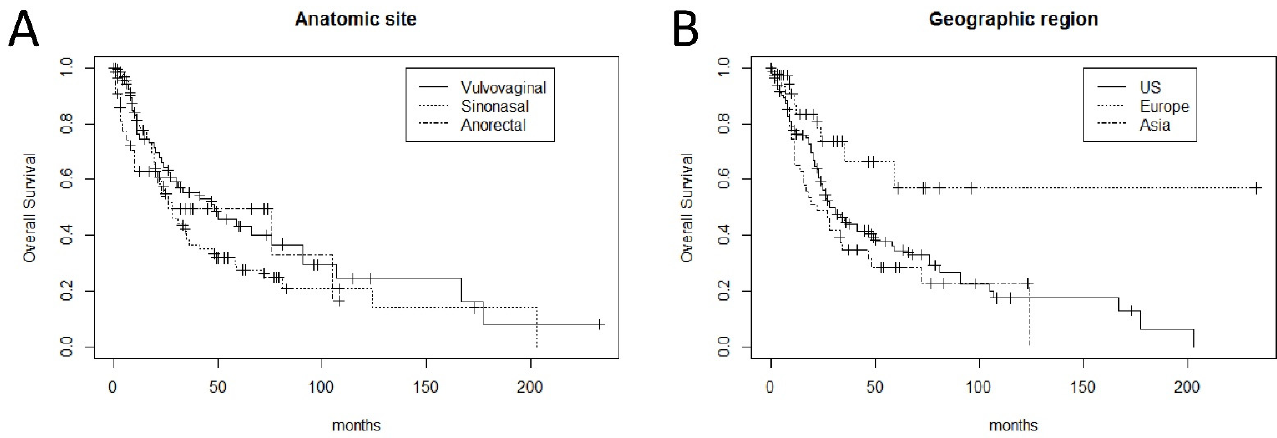
Figure 1. ( A ) Kaplan–Meier curves demonstrate no significant correlation between overall survival and anatomic sites (log-rank p = 0.3); ( B ) Kaplan–Meier curves demonstrate a significant correlation between overall survival and geographic areas (log-rank p = 0.01).